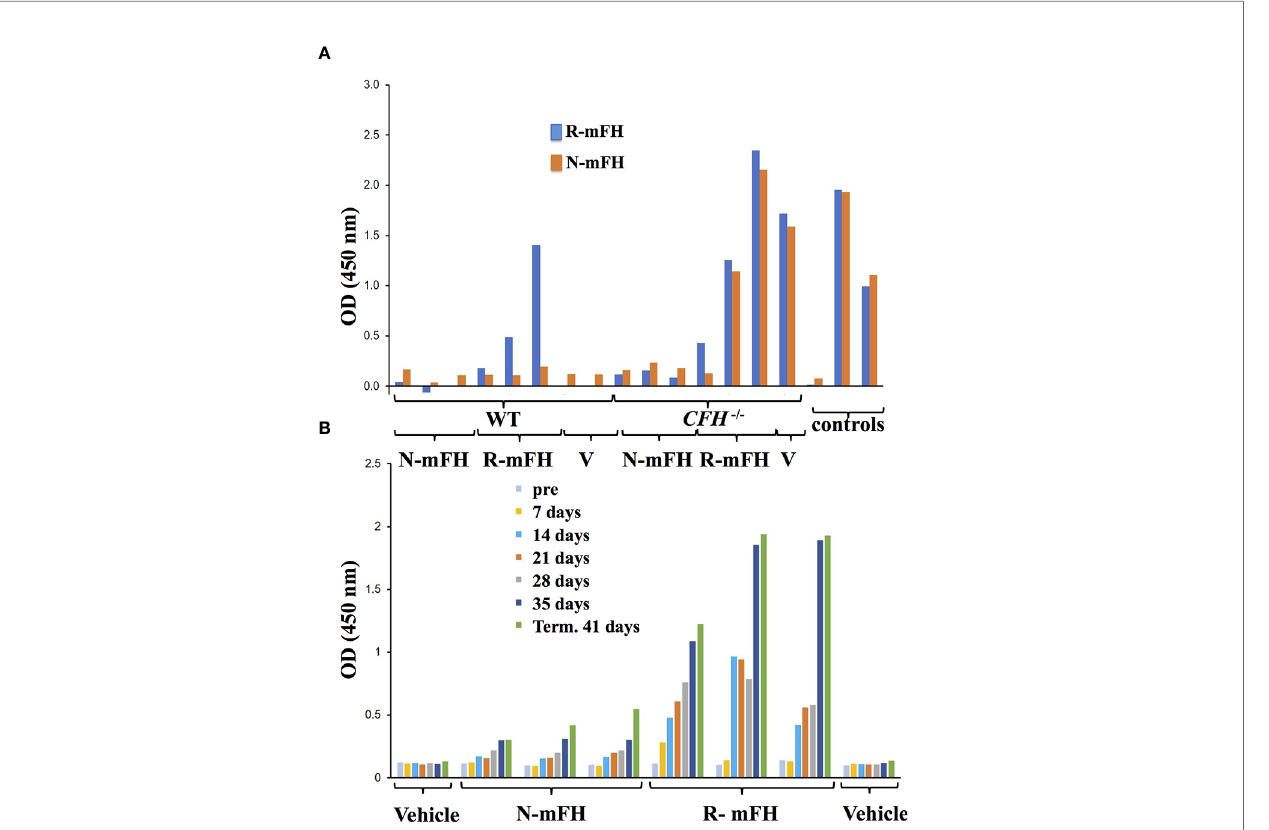
FIGURE 7 | Anti-FH antibodies induced by dosing with recombinant FH. (A) A test of whether injections of native [plasma-derived) mFH or rmFH or vehicle (V)] into wild-type mice induce antibodies recognising native mFH (N-mFH), or recombinant mFH (R-mFH). Positive control: 1/250,000 dilution of mouse monoclonal antibody to mFH. (B) Emergence of anti-FH antibodies over time after dosing in three two-month-old CFH -/- mice (displaying mild or little clinical phenotype at this point). OD 450 nm in (A, B) are read-outs of tetramethylbenzidine exposed to bound HRP-conjugated sheep anti-mouse IgG antibody (Jackson ImmunoResearch); the means of triplicates are